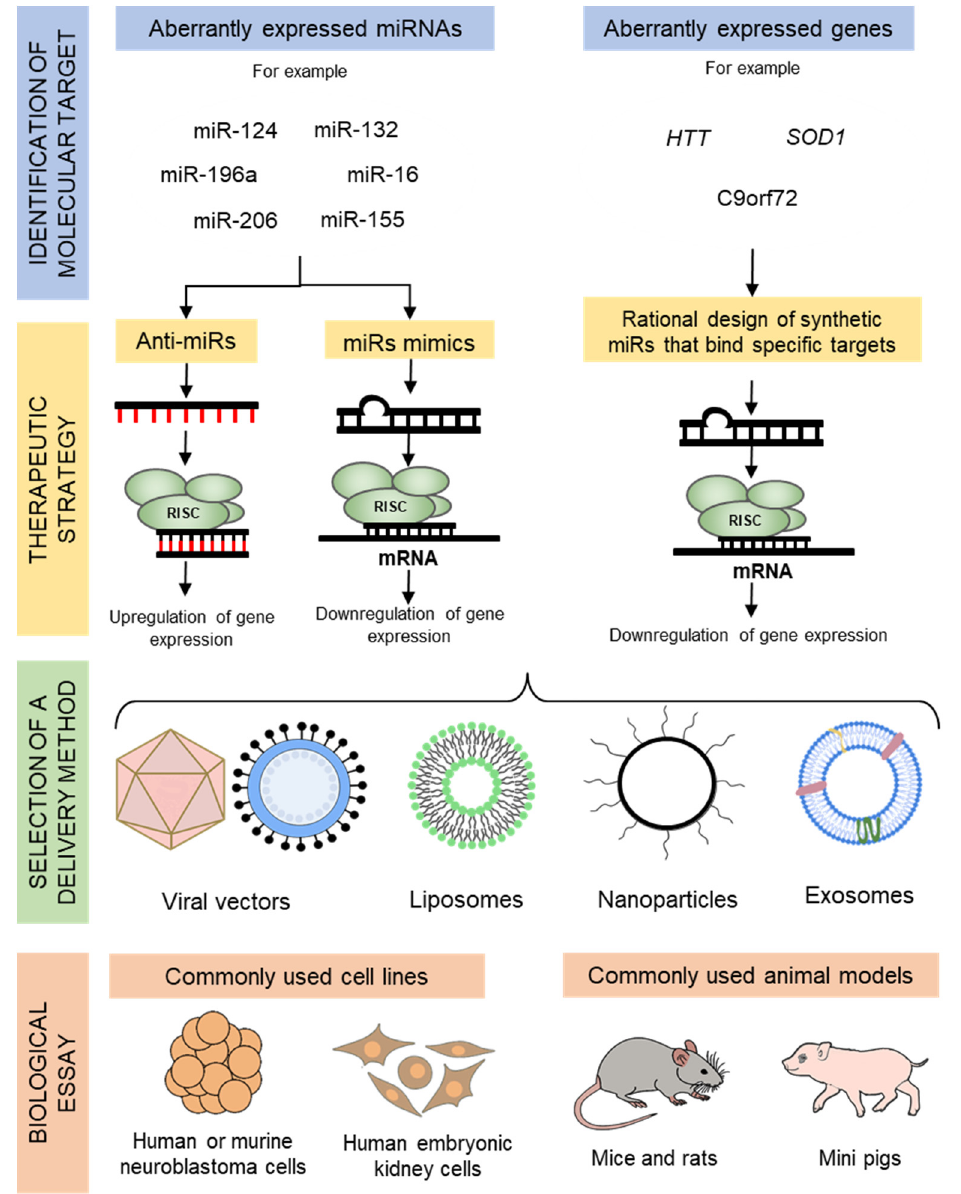
Figure 2. The general flow for designing and testing a miRNA-based therapeutic approach to treat neurodegenerative diseases. Firstly, abnormally expressed miRNAs are detected in patients’ tissues, and are then later regulated by inhibiting or enhancing their function. Otherwise, specific synthetic miRNAs can be designed to target genes of interest. Later, these miRs must enter cells by an appropriate delivery system. The e ff ect of administered miRNAs is then assessed in biologic